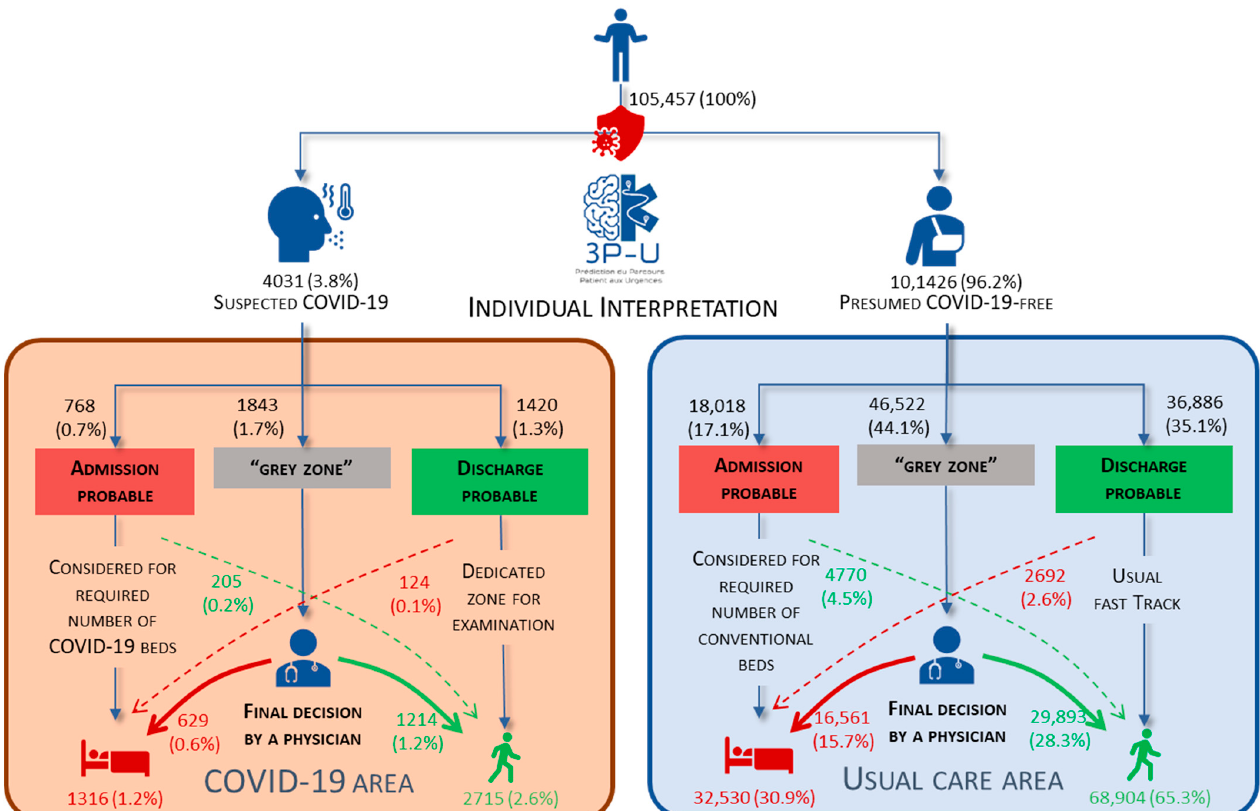
Figure 4. Individual triage prediction in the Amiens Picardy University Hospital (Amiens, France)